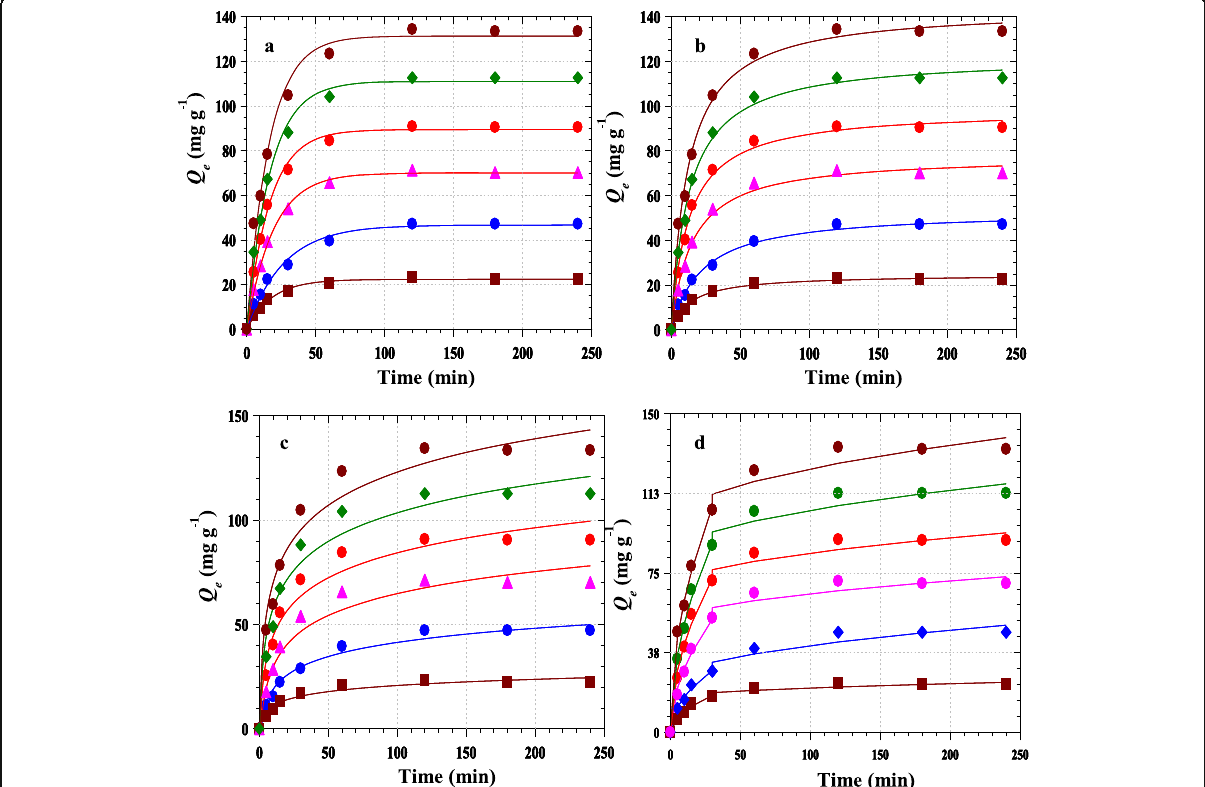
Fig. 12 Least square fit of Q t versus t of kinetic plots for the removal of Cd(II) ions on BMDA a first-order, b second-order, c Elovich fits, and d intraparticle diffusion models (adsorbent dosage, 0.04 g/L; pH, 6.0; and temp, 30